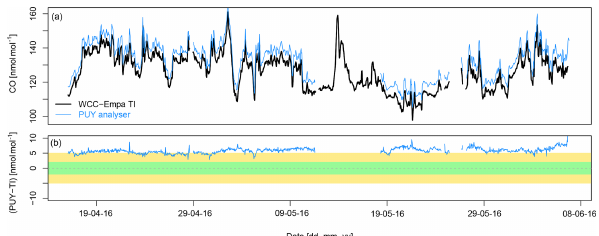
Figure 7. Comparison of hourly averages of CO at PUY between the WCC-Empa travelling instrument and the PUY Picarro G2401 for the period when the TI sampled humid air. (a) CO time series. (b) CO bias of the station analyser vs. time. The green and yellow areas correspond to the WMO network compatibility and extended network compatibility goals.